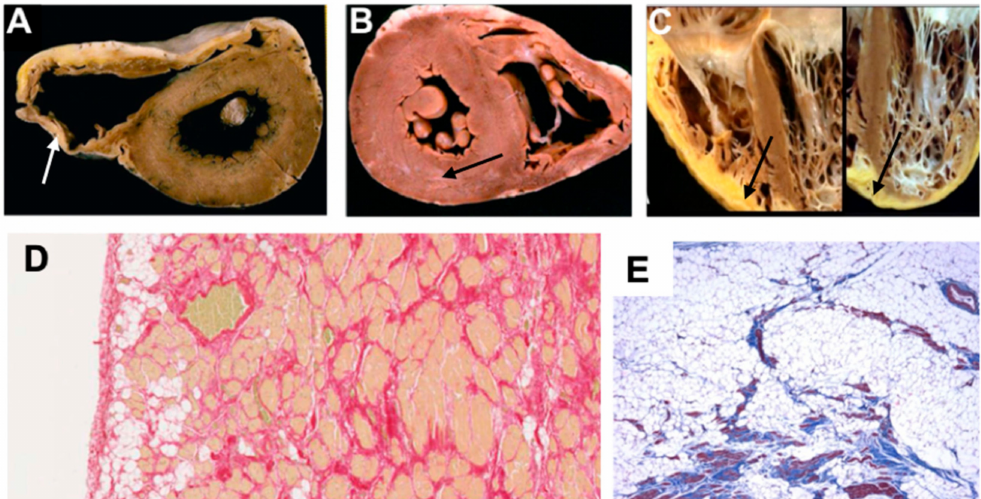
Figure 1. Explanted heart images showing pathological features of di ff erent phenotypes in ACM, adapted from Calkins (2013) [10], Thiene et al. (2016) [11], Corrado et al. (2020) [12]. ( A ) Gross specimen shows dilated thin RV, fatty replacement of entire RV free wall epicardium and thin fibrotic endocardium (white arrow). ( B ) Gross specimen shows little evidence of RV involvement, however subepicardial grey band of fibrotic tissue (black arrow) is seen in the posterolateral section of the LV. ( C ) Gross specimen shows fibro-fatty biventricular involvement (black arrows). ( D ) Histology image shows fat replacement extending from epicardium to endocardium. ( E ) Histology image with trichrome staining identifies fibrous scars within fat tissue. LV = left ventricle; RV = right ventricle. Table 1. Summary of evolving definition and classification of cardiomyopathies and